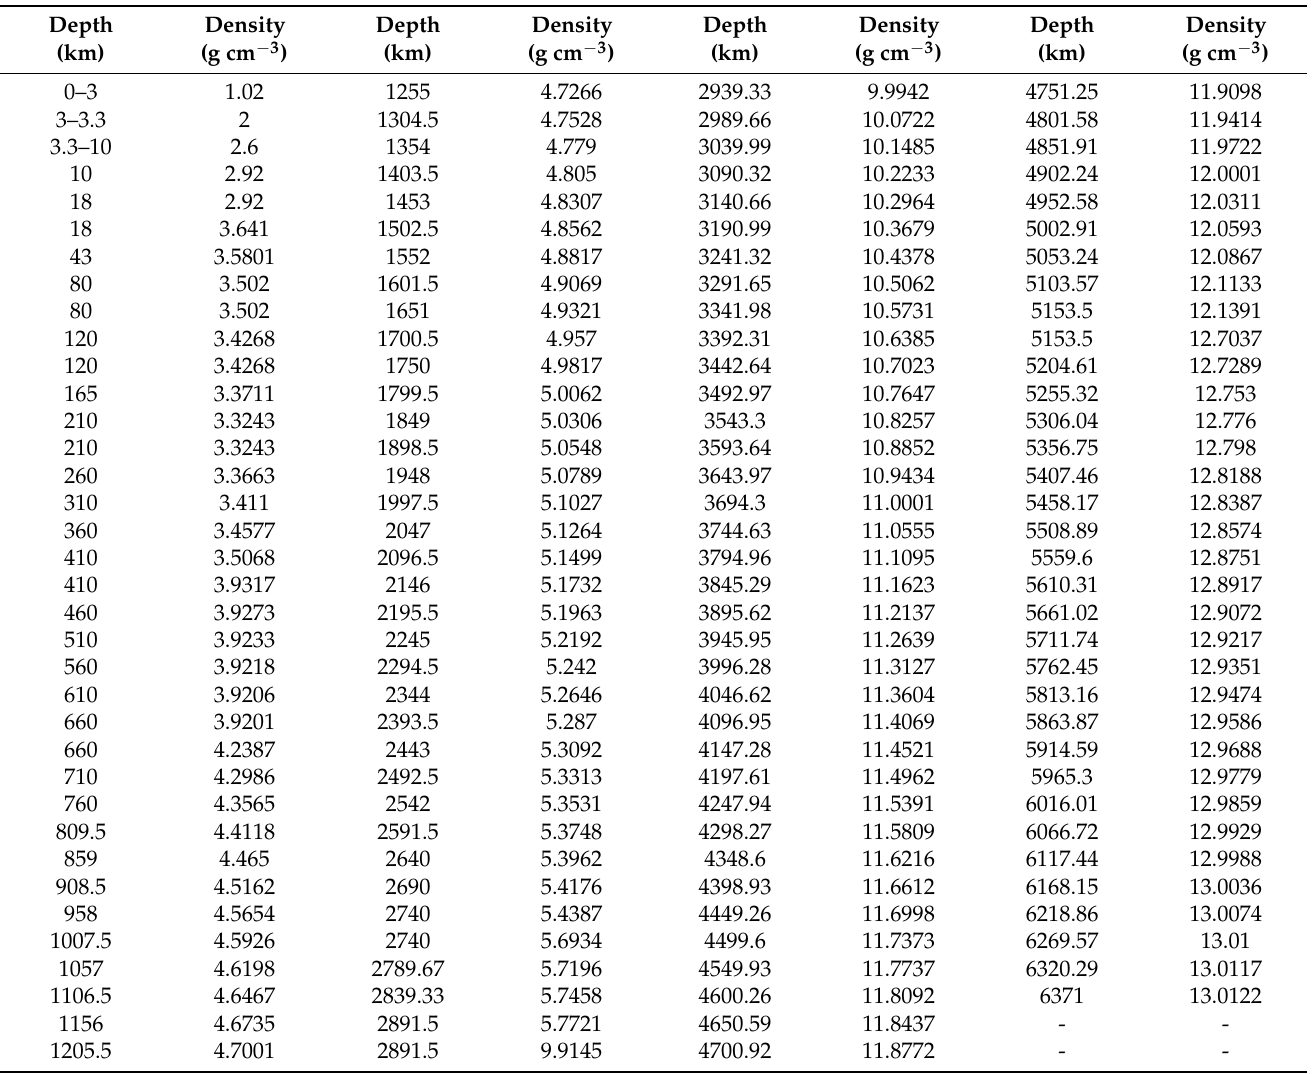
Table 2. The AK135-F density parameters according to